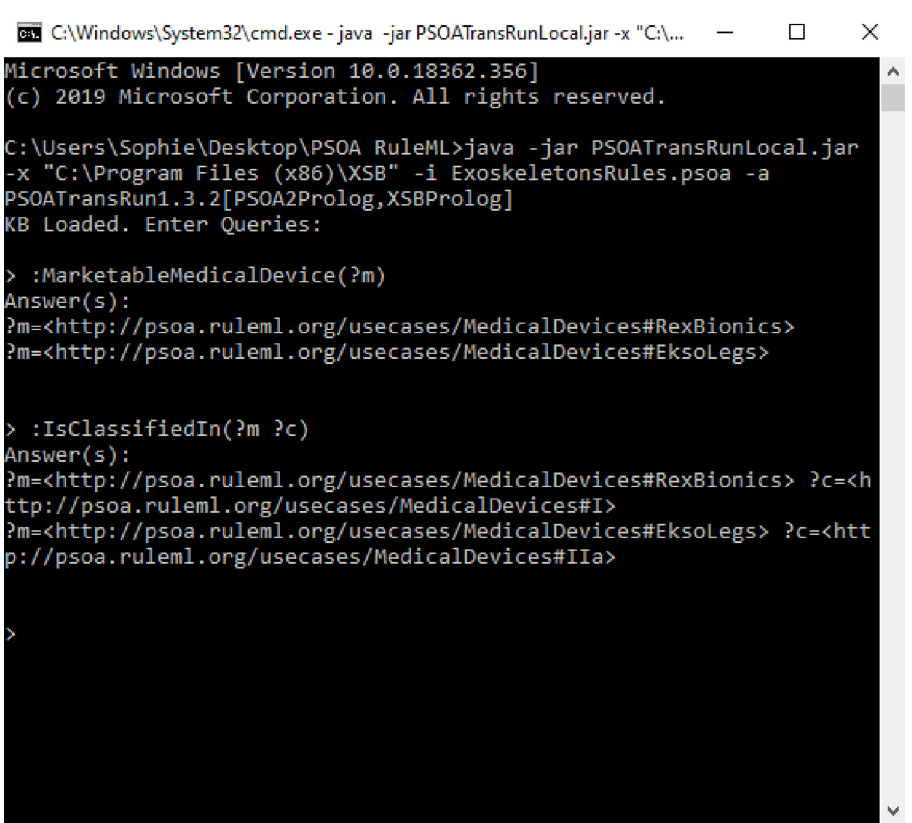
Figure 4: Queries in Positional - Slotted Object - Applicative TransRun ( PSOATransRun )